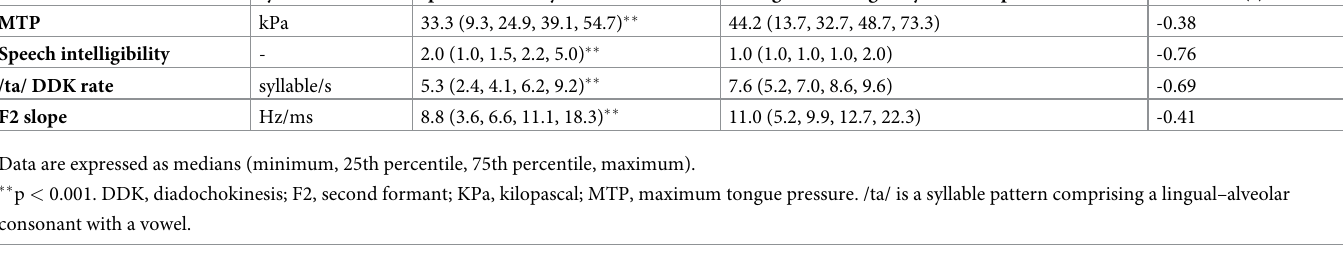
Table 3. Correlation coefficients (two sided) between maximum tongue pressure and speech measures for speak- ers with dysarthria (n = 63). Speech measures Correlation coefficients